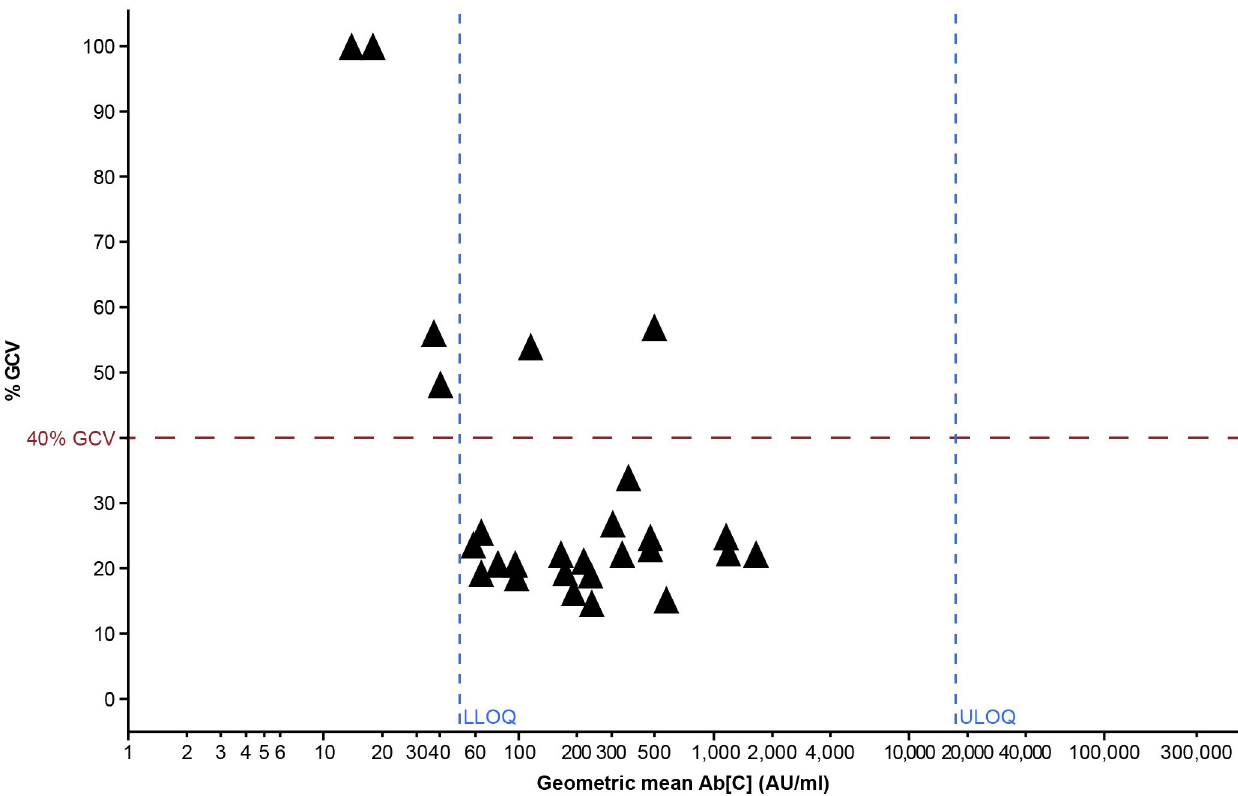
Fig 1. Anti-SARS-CoV-2-neutralizing antibody MNT assay precision. Precision profiles are shown across increasing geometric mean Ab[C]s (across 18 assay runs); precision profiles for QC samples are also shown. The horizontal red line shows the pre-defined %GCV criterion of < 40%. Vertical blue dashed lines represent the LOQs; %GCV values that exceed the Y-axis maximum value are displayed as 100% GCV. Ab[C] = antibody concentration; AU = arbitrary units; %GCV = percent geometric coefficient of variation; LLOQ = lower limit of quantitation; QC = quality control; SARS-CoV-2 = severe acute respiratory syndrome coronavirus 2; ULOQ = upper limit of